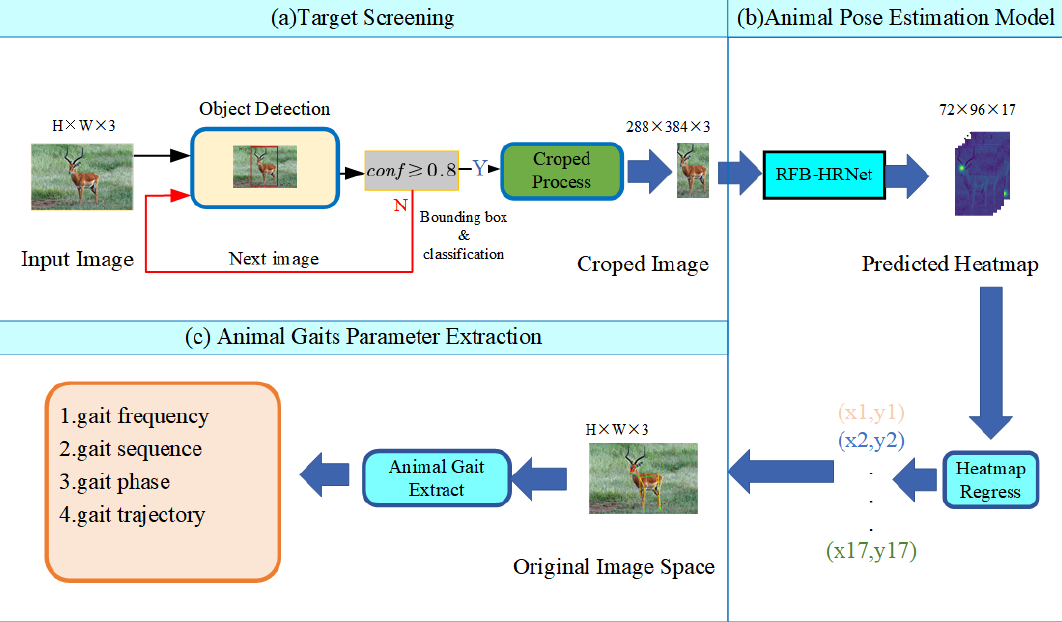
Figure 1. Quadruped animal pose estimation and animal gait parameter extraction computational framework.